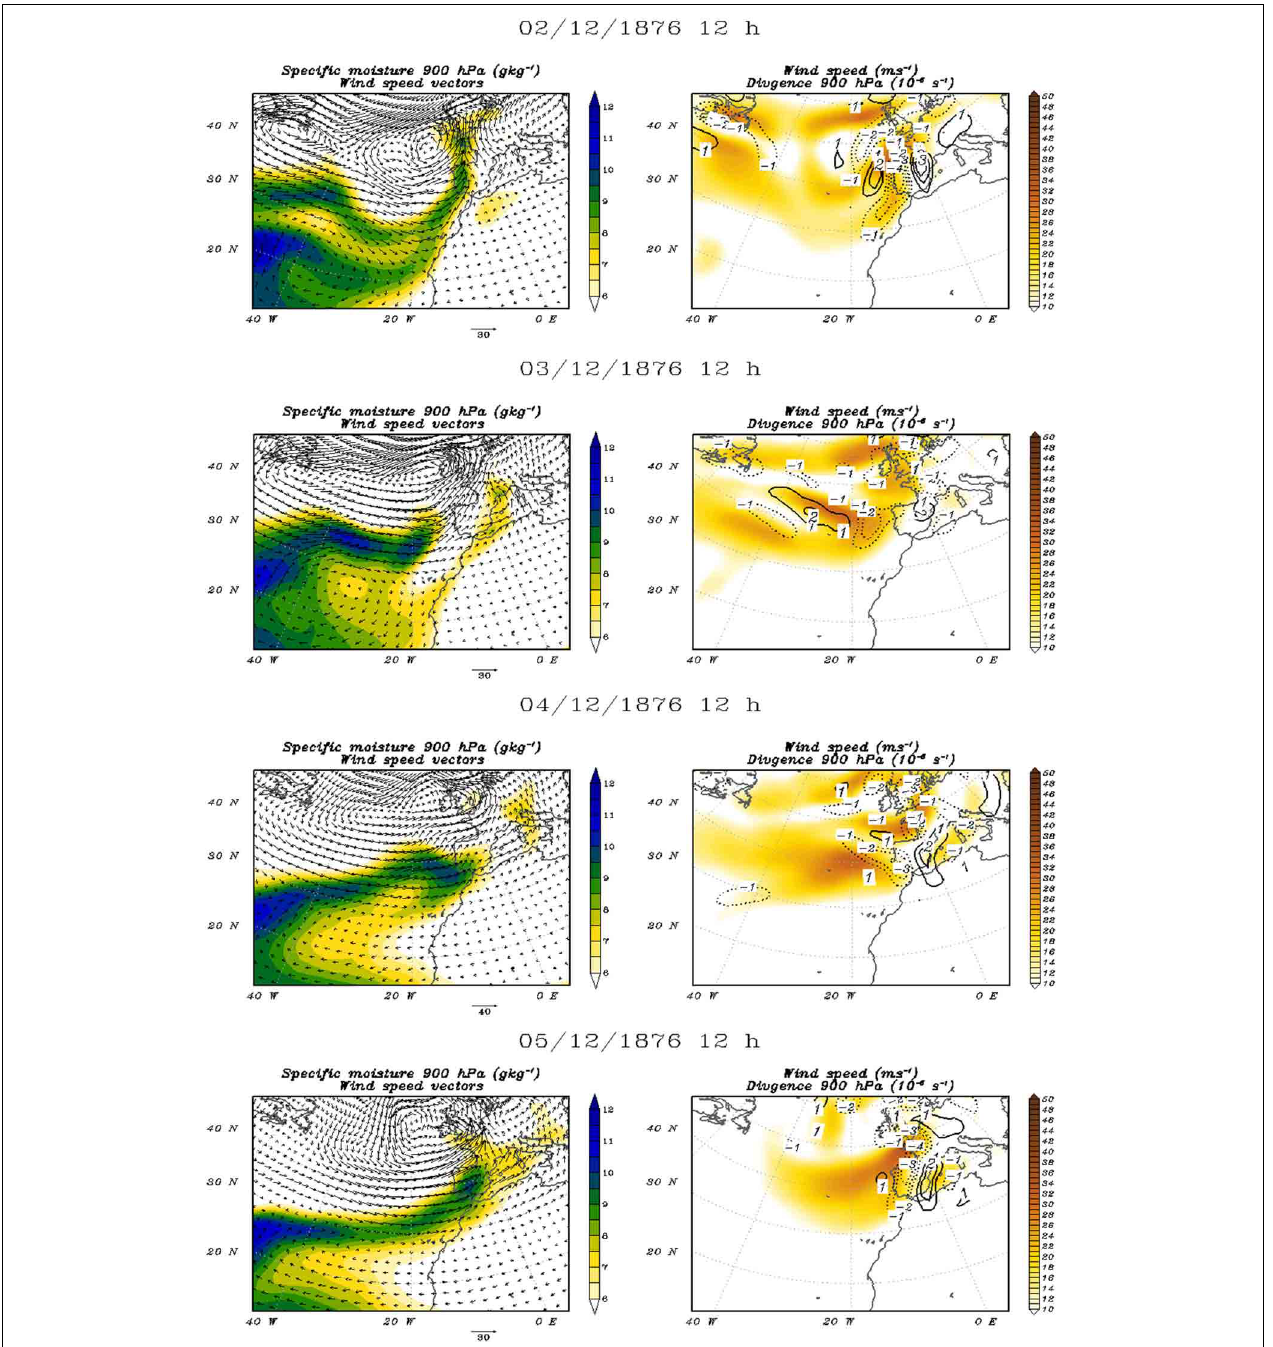
FIGURE 13 | Wind speed and direction (arrows) and specific moisture (gkg − 1 ) color contours at 900hPa (left panels) , wind speed intensity (colors, ms − 1 ) and divergence (solid) and convergence (dotted) contours at 900hPa (right panels) for selected